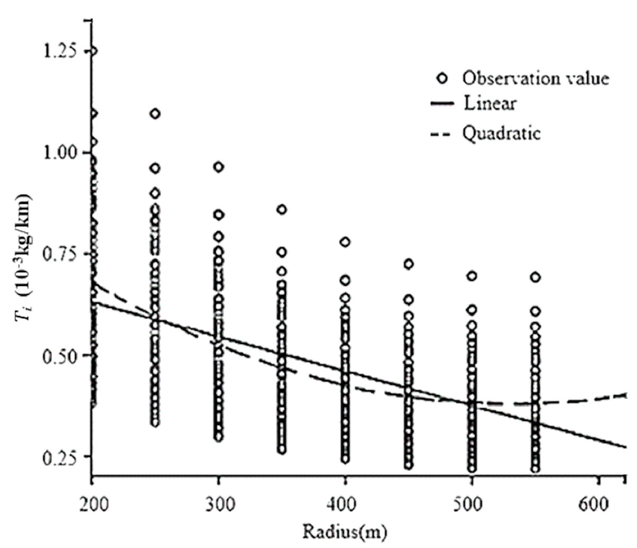
Figure 6. Regression models. Table 9. Fitting parameters.